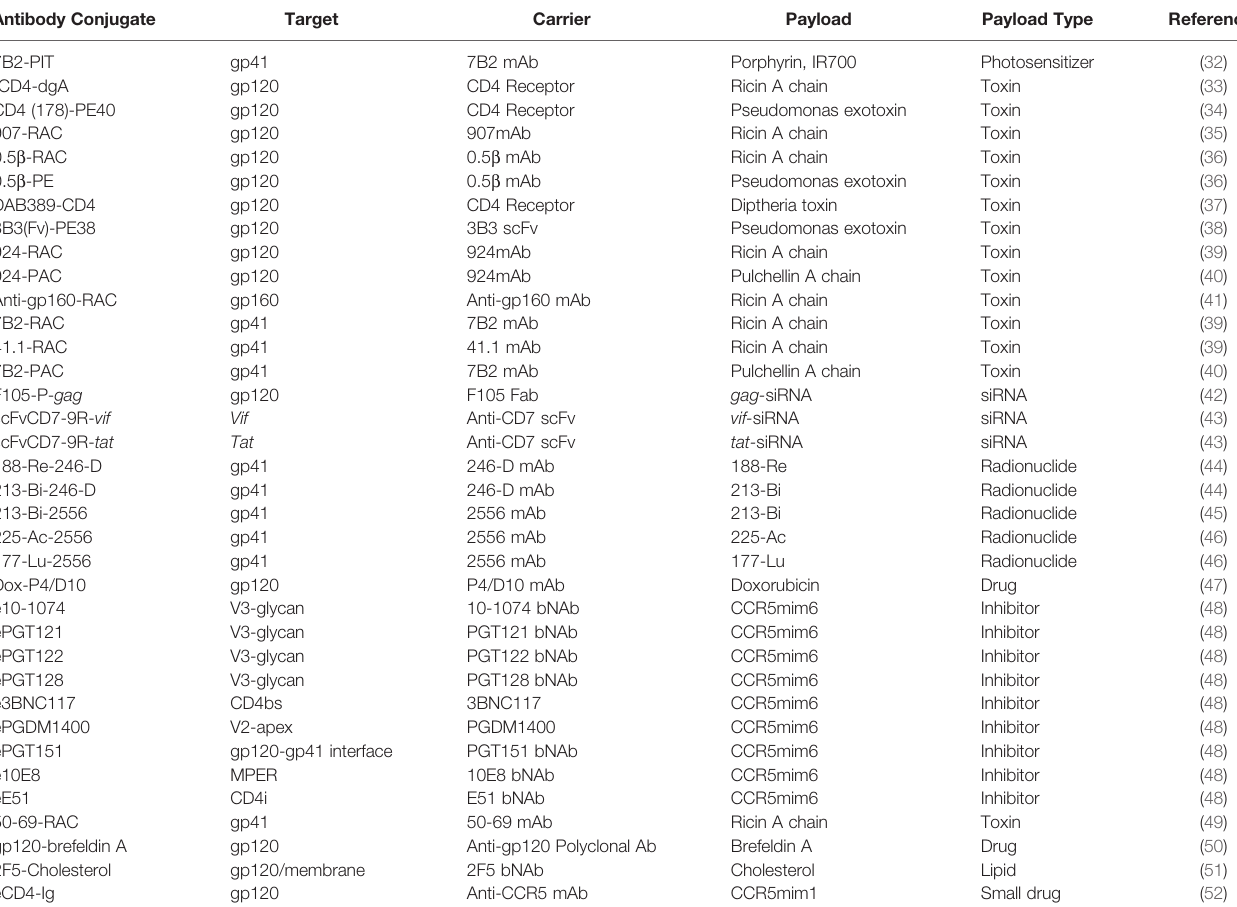
TABLE 2 | Virus-directed antibody conjugates. Antibody